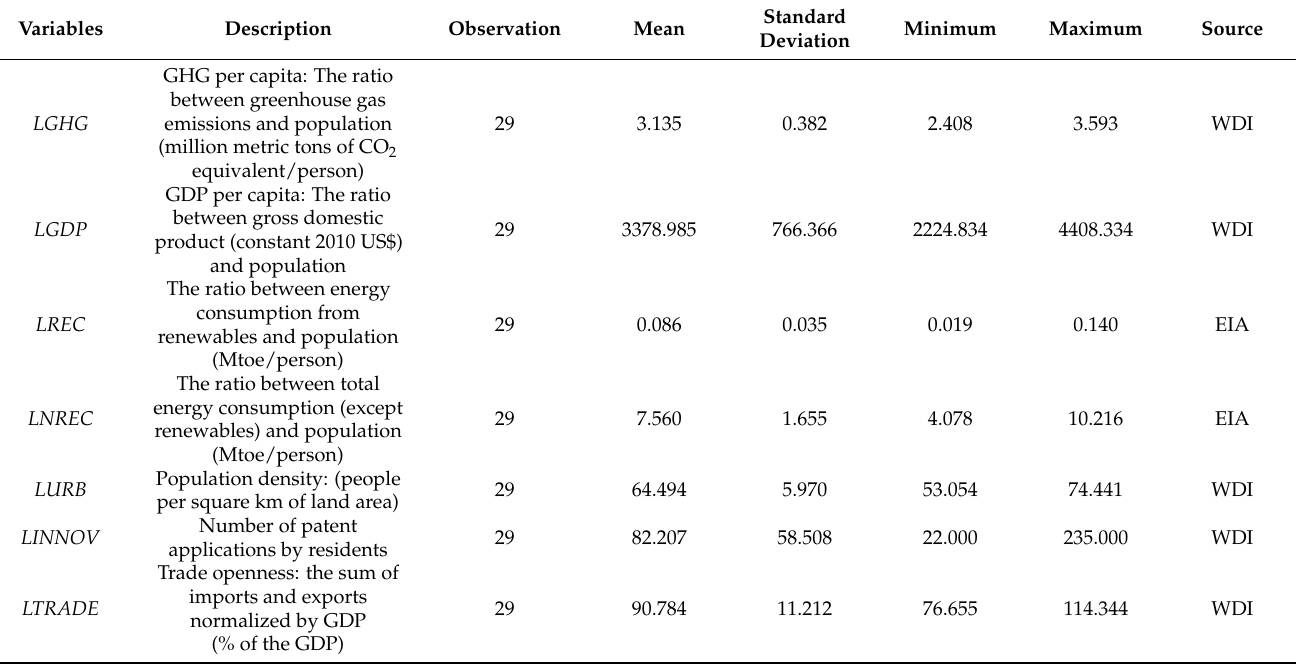
Table 1. Variables’ definition and Descriptive